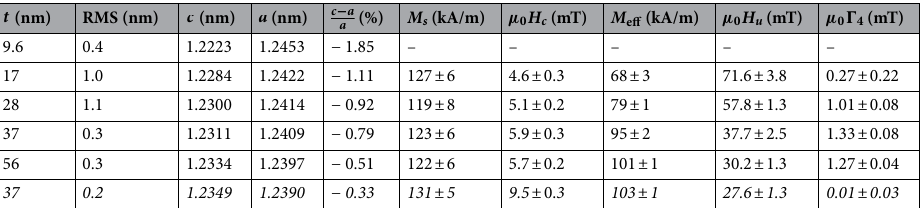
Table 1. Structural and magnetic properties of YIG films deposited on YAG and GGG (italic)